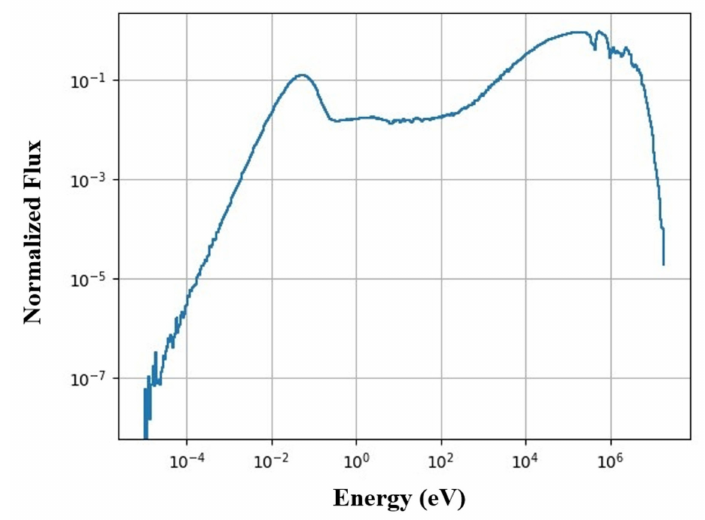
Figure 4. Energy spectra diagram of ADSR of thermal spectrum (k eff =